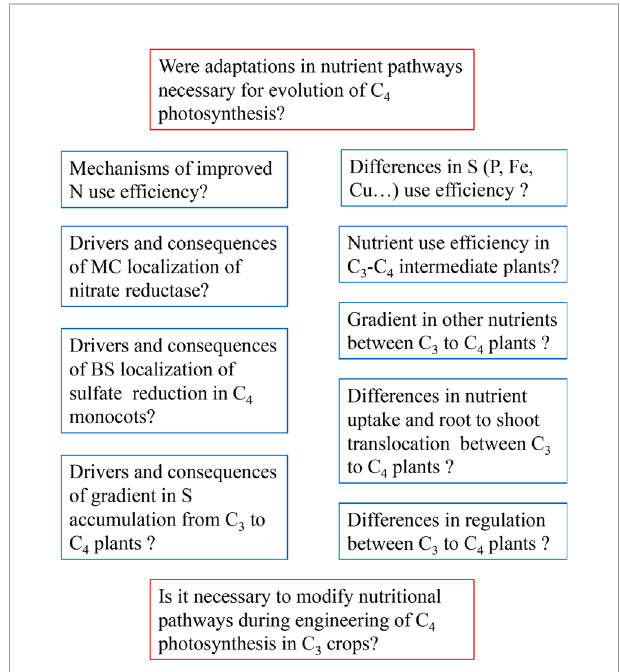
FIGURE 2 | Summary of major research questions in mineral nutrition of C 4